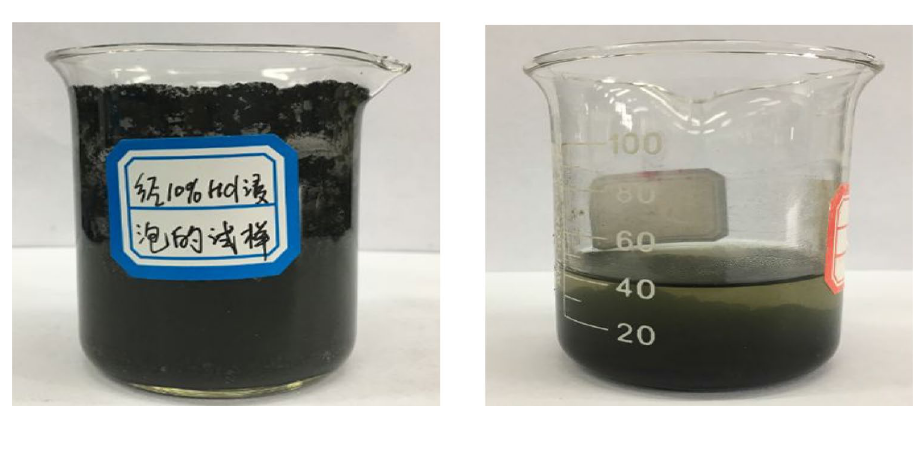
Table 4 Dissolution rate of the blockage samples in 10% hydrochloric acid solution and